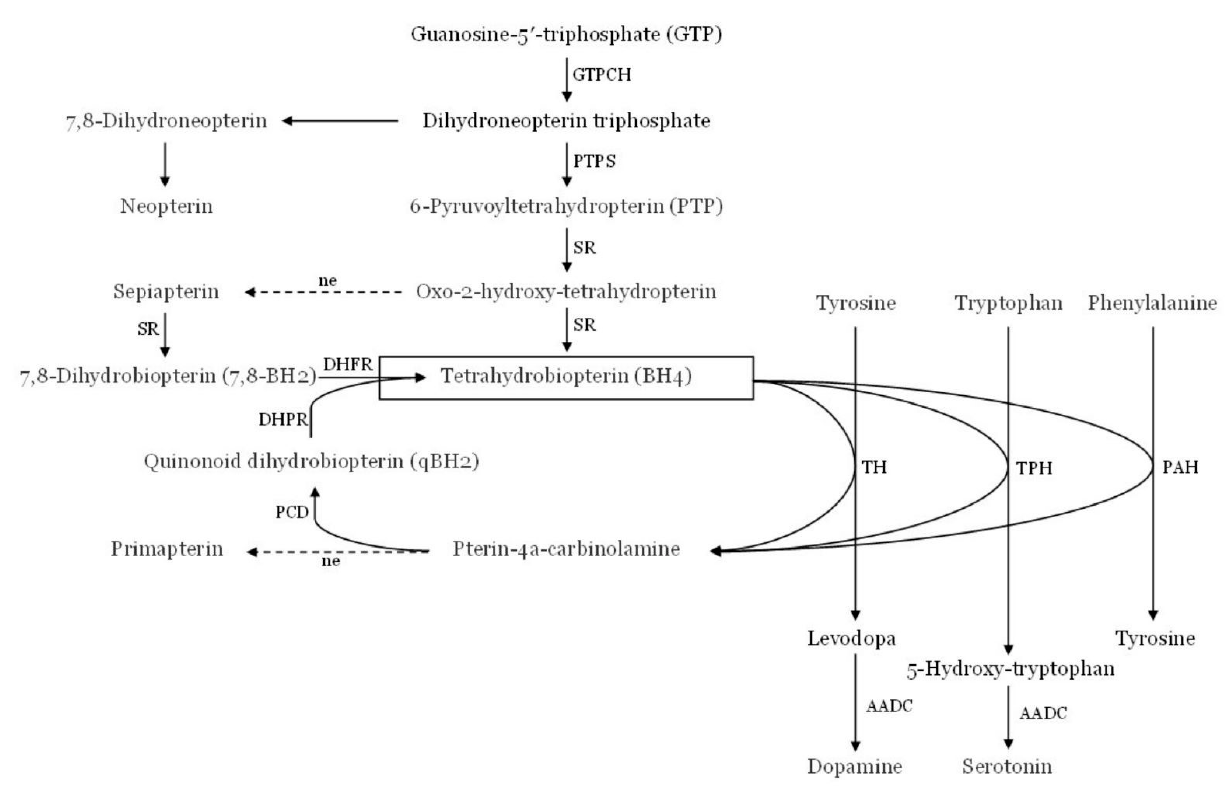
Figure 1. The metabolic pathway of tetrahydrobiopterin (BH4). AADC, aromatic amino acid de- carboxylase; DHFR, dihydrofolate reductase; DHPR, dihydropteridine reductase; GTPCH, GTP cyclohydrolase 1; ne, non-enzymatic; PAH, phenylalanine hydroxylase; PCD, pterin-4a-carbinolamin dehydratase; PTPS, 6-pyruvoyltetrahydropterin synthase; SR, sepiapterin reductase; TH, tyrosine hydroxylase; TPH, tryptophan hydroxylase (adapted from Ref. [3], Figure